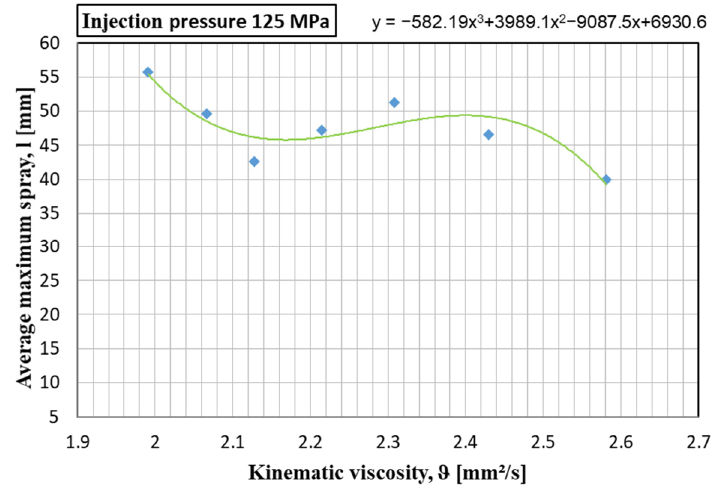
Figure 11. Maximum range of spray tip with the trend line determined for injection pressure of 125 MPa.